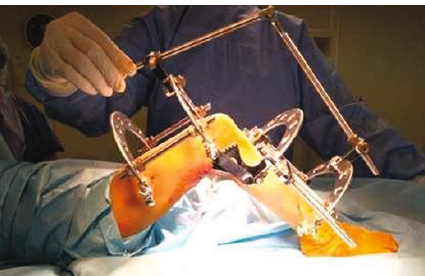
Figure 2: Extension of the hamstring tendons and installation of the external distraction apparatus through the application of Volkov- Oganesyan. A special ellipsoid hinge, simultaneously with the extension of the tibia, slightly shifts the anterior articular surface of the tibia, thereby preventing the formation of a posterior